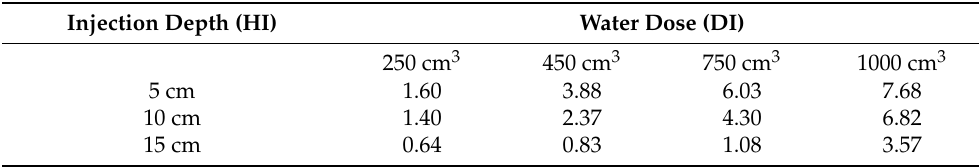
Table 1. Total evaporation from the moment of injection until day 15 ( E 1 − 15 ) (mm).